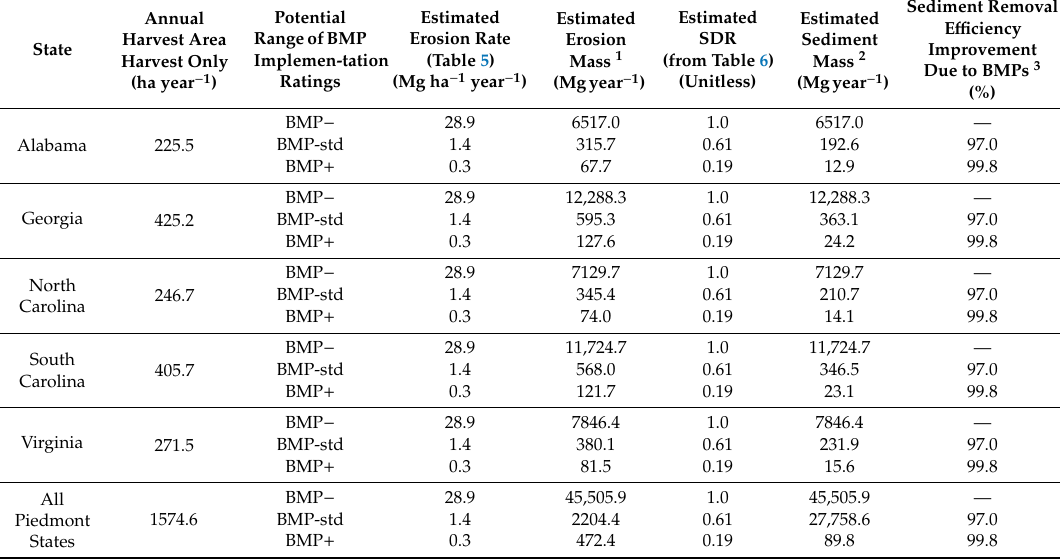
Table 8. Estimated erosion rates, erosion, masses, sediment delivery, and sediment removal e ffi ciencies due to BMP implementation levels by state for forest roads.